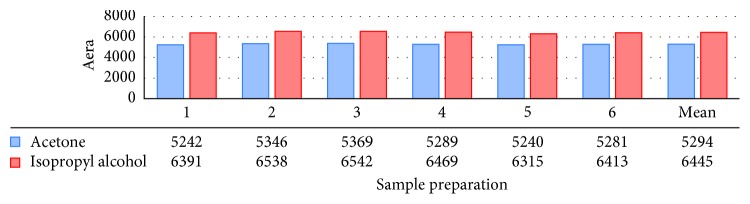
Method precision.